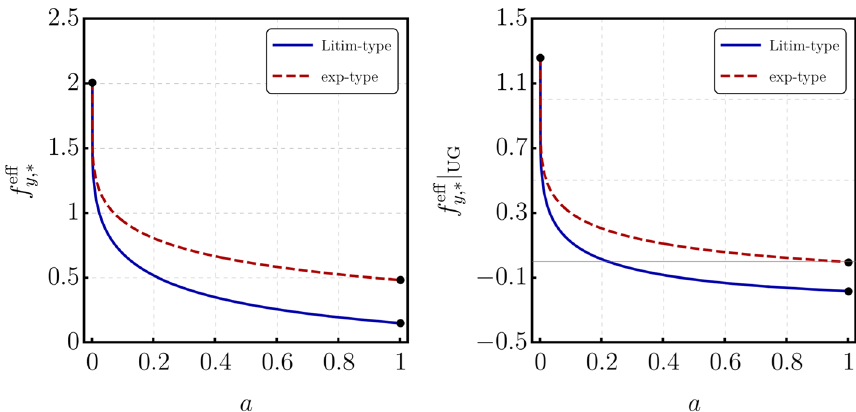
Fig. 5 Left panel: We show the effective scaling dimension at the fixed point with finite gauge and vanishing Yukawa coupling, f eff y , ∗ in standard gravity for the exponential (red, dashed line) and Litim-type (blue continuous line) regulator. Right panel: We show f eff y , ∗ in unimodular gravity for the two shape